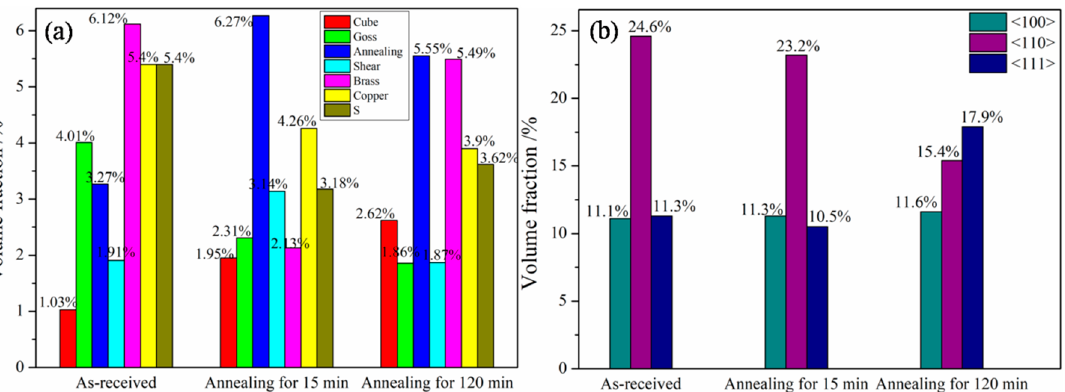
Figure 7. Texture components of the recrystallized grains: ( a ) plate texture and ( b ) fiber texture.